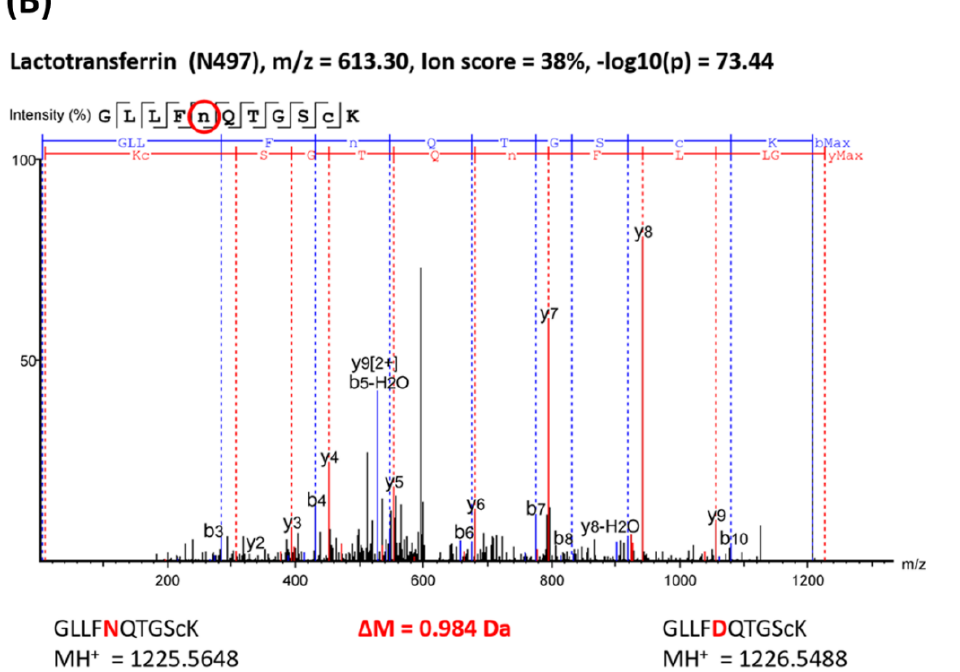
Figure 4. The MS-based detection of tear glycoprotein lactotransferrin (LTF) and characterization of its specific N-glycosylation sites. ( A ) The identified sequence of enriched glycoprotein LTF which was either pre-treated with PNGase F or served as an untreated control (CTRL) group. The enzymatic-induced N-glycosylation sites N497 and N642 are marked in the respective sequence parts of LTF + PNGase F treatment but are not present in the untreated CTRL group. ( B ) The MS/MS spec- trum of an N-glycopeptide from LTF indicating the glycosylation site at N497. The red-colored amino acid within the sequence marks the N-glycosylation site which was deamidated from asparagine (N) to aspartic acid (D) due to the enzymatic release of the N-glycan. This enzymatic-induced modification results in a mass shift of +0.984 Da which can be detected by high-resolution MS.